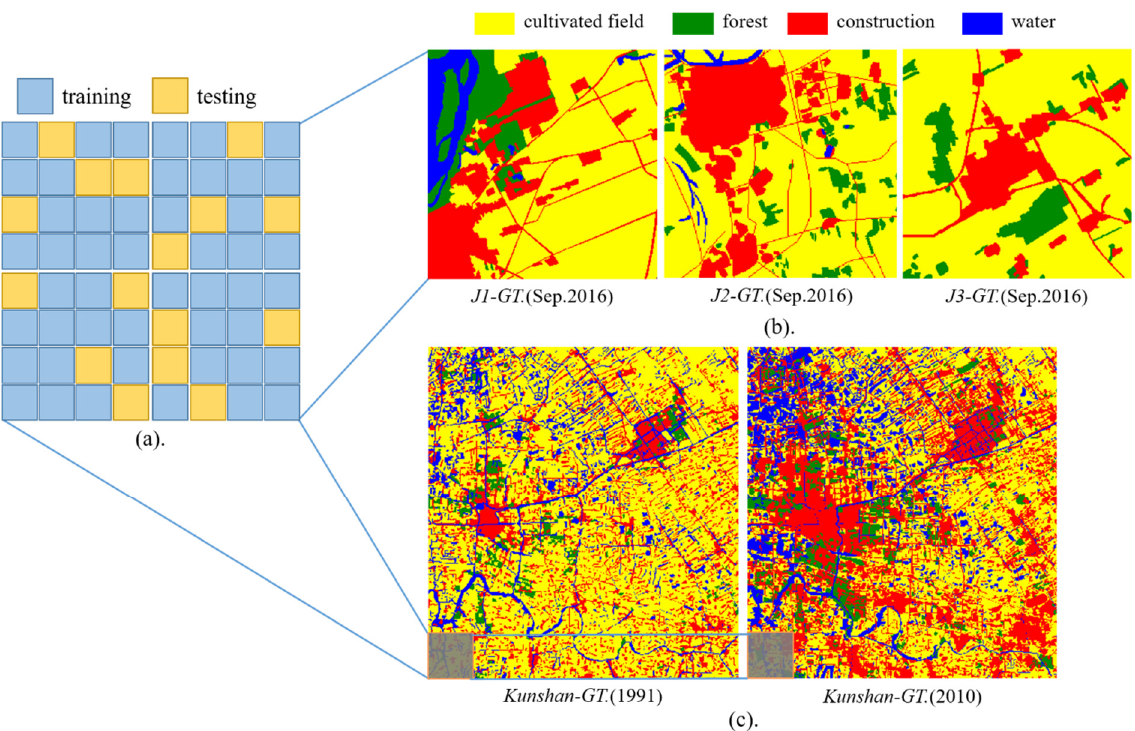
Figure 6. The ground truth information (GT) and data division. ( a ) The training samples (blue boxes) and testing samples (orange boxes) are randomly selected at a ratio of 3:1 from several equal-sized images blocks; ( b ) the labels of Jiamusi ( J1, J2, and J3 ) in September 2016 (corresponding to the cloud-free images in Figure 5); ( c ) the labels of Kunshan in 1990 and 2010, where the gray boxes represent only a small part of the large-scale data set.